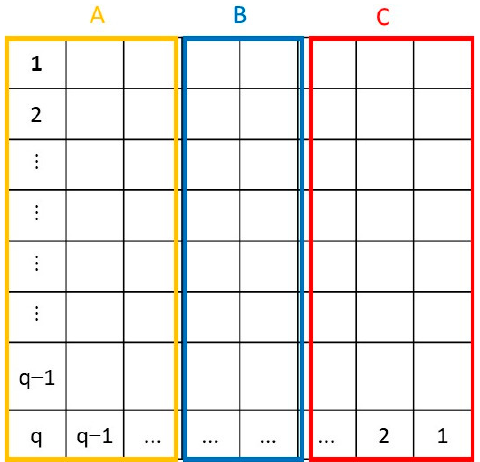
Figure 3. Thermal IR sensor arrangement.